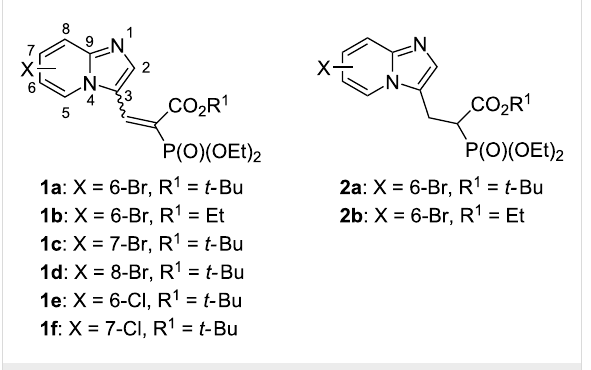
Figure 1: Substrates used for the Mizoroki–Heck reaction in this